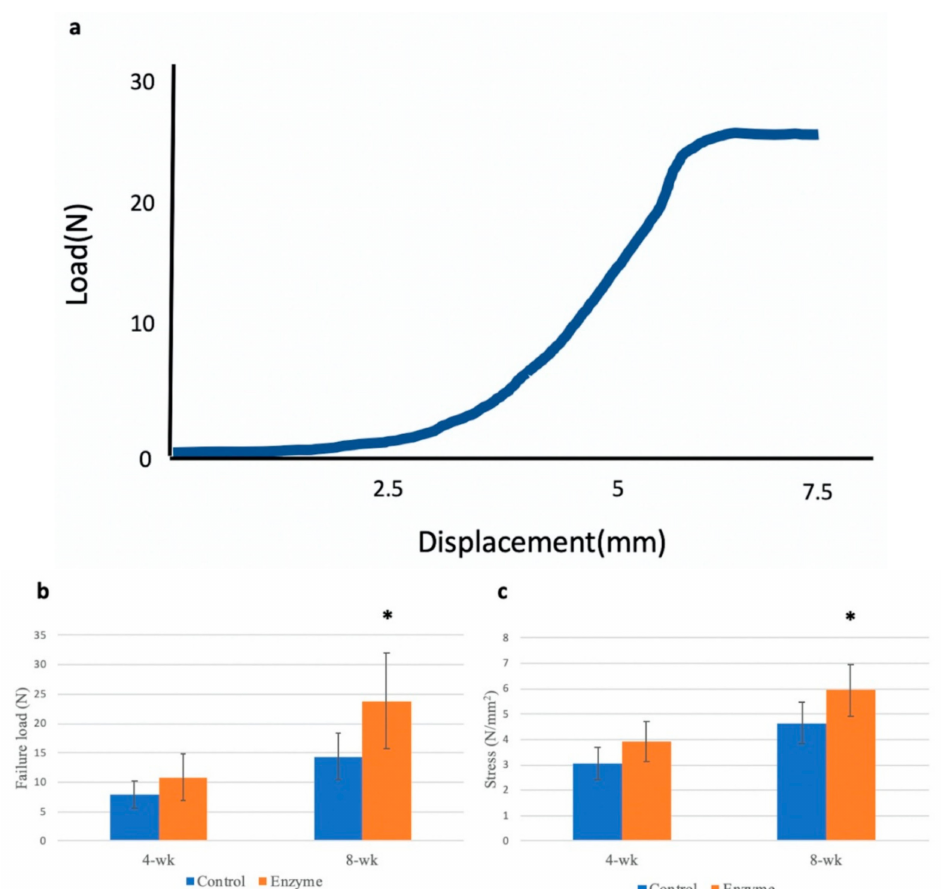
Figure 10. Biomechanical assessment. Original load-deformation curve in the 8-week enzyme-treated specimen. ( a ) Significantly higher tendon ultimate load-to-failure and stress were found in the enzyme treatment group than in the control group at 8 weeks. * p < 0.05, n = 8. ( b , c ) The error bars designed the standard